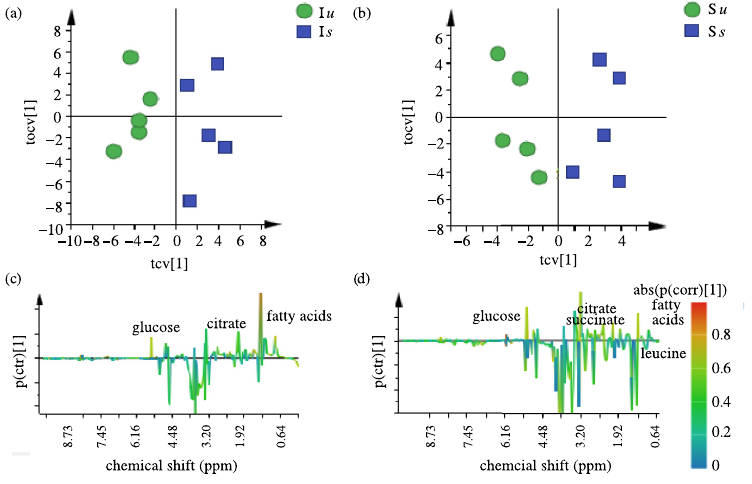
Fig 5. OPLS-DA analysis to see the effect of prick injury. (a) OPLS-DA score plot for I s -I u comparison, (b) OPLS-DA score plot for S s -S u comparison, (c) S-line plot for I s -I u comparison and (d) S-line plot for S s -S u